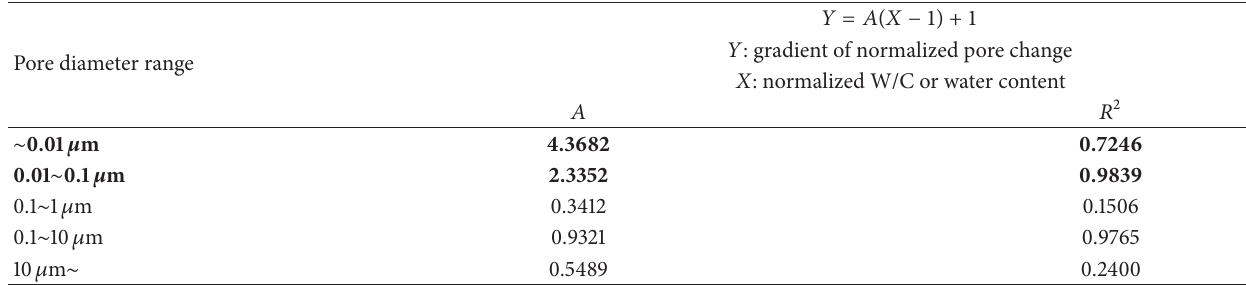
Table 6: Regression analysis for various ranges of porosity and W/C